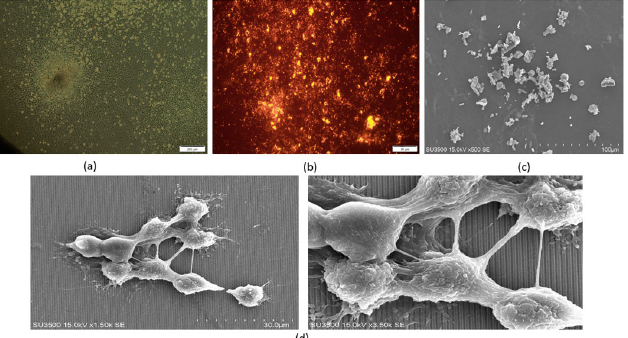
Fig 4. (a). Normal image of cardiomyocyte cells under an inverted microscope, (b). Image of cardiomyocyte cells stained with a DiI dye under an inverted microscope, (c) SEM image of cardiomyocyte cells cultured on cell culture plate, (d) SEM image of cardiomyocyte cells cultured on a one-dimensional plasmonic